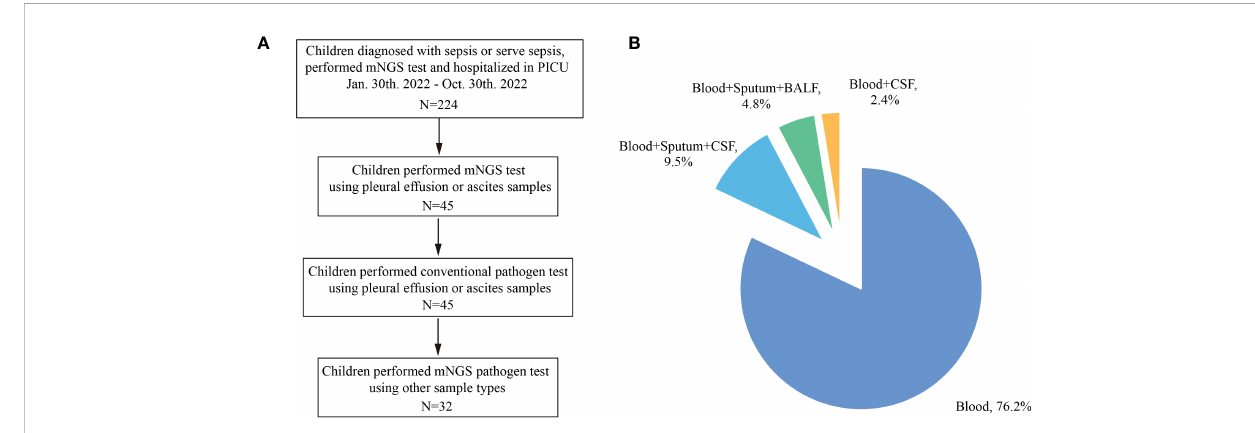
FIGURE 1 Sampling strategy. (A) fl ow graph showing the patient screening procedures; (B) pie graph showing the performed mNGS test of included